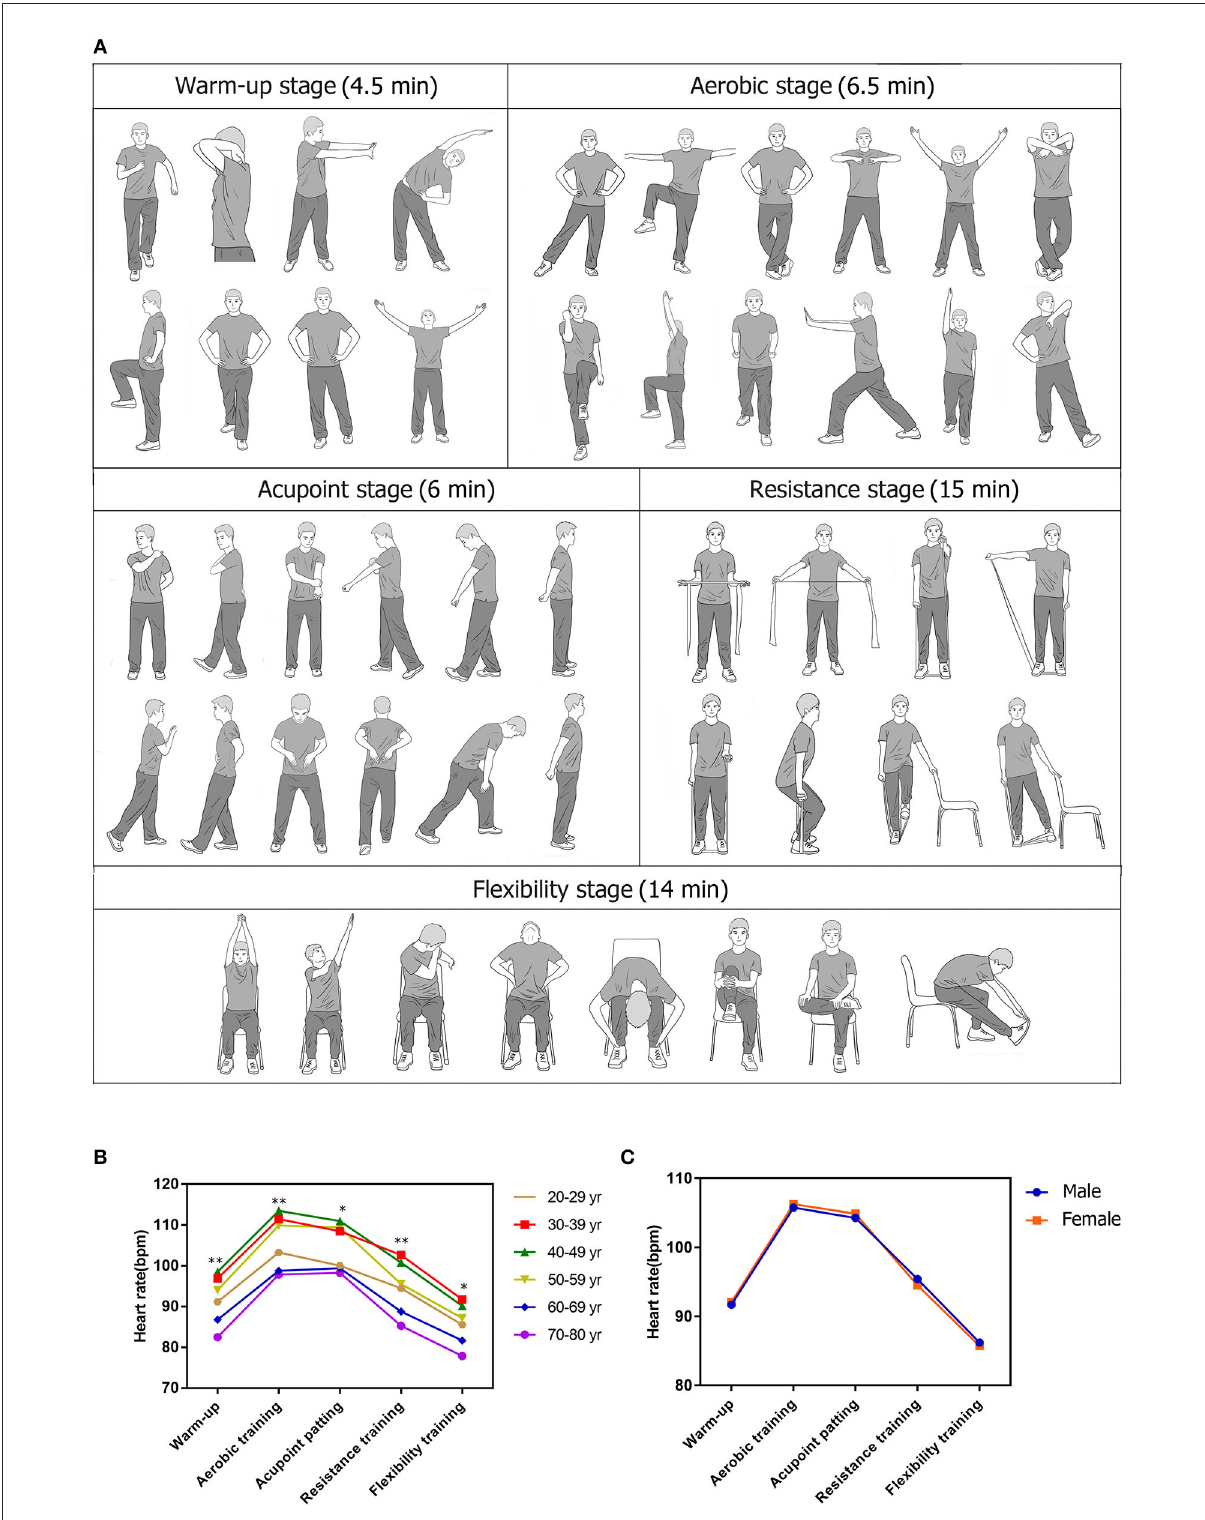
FIGURE2 Actions, heart rate (HR) response of Xiangya Hospital Circuit Training (X-CircuiT). (A) shows an excerpt of X-CircuiT actions; (B,C) presents the heart rate response of X-CircuiT in the different age or sex groups, respectively. * Indicates the difference between groups p < 0.05; ** indicates the difference between groups p < 0.01 (ANOVA) in (B) ; An independent sample t -test in (C)